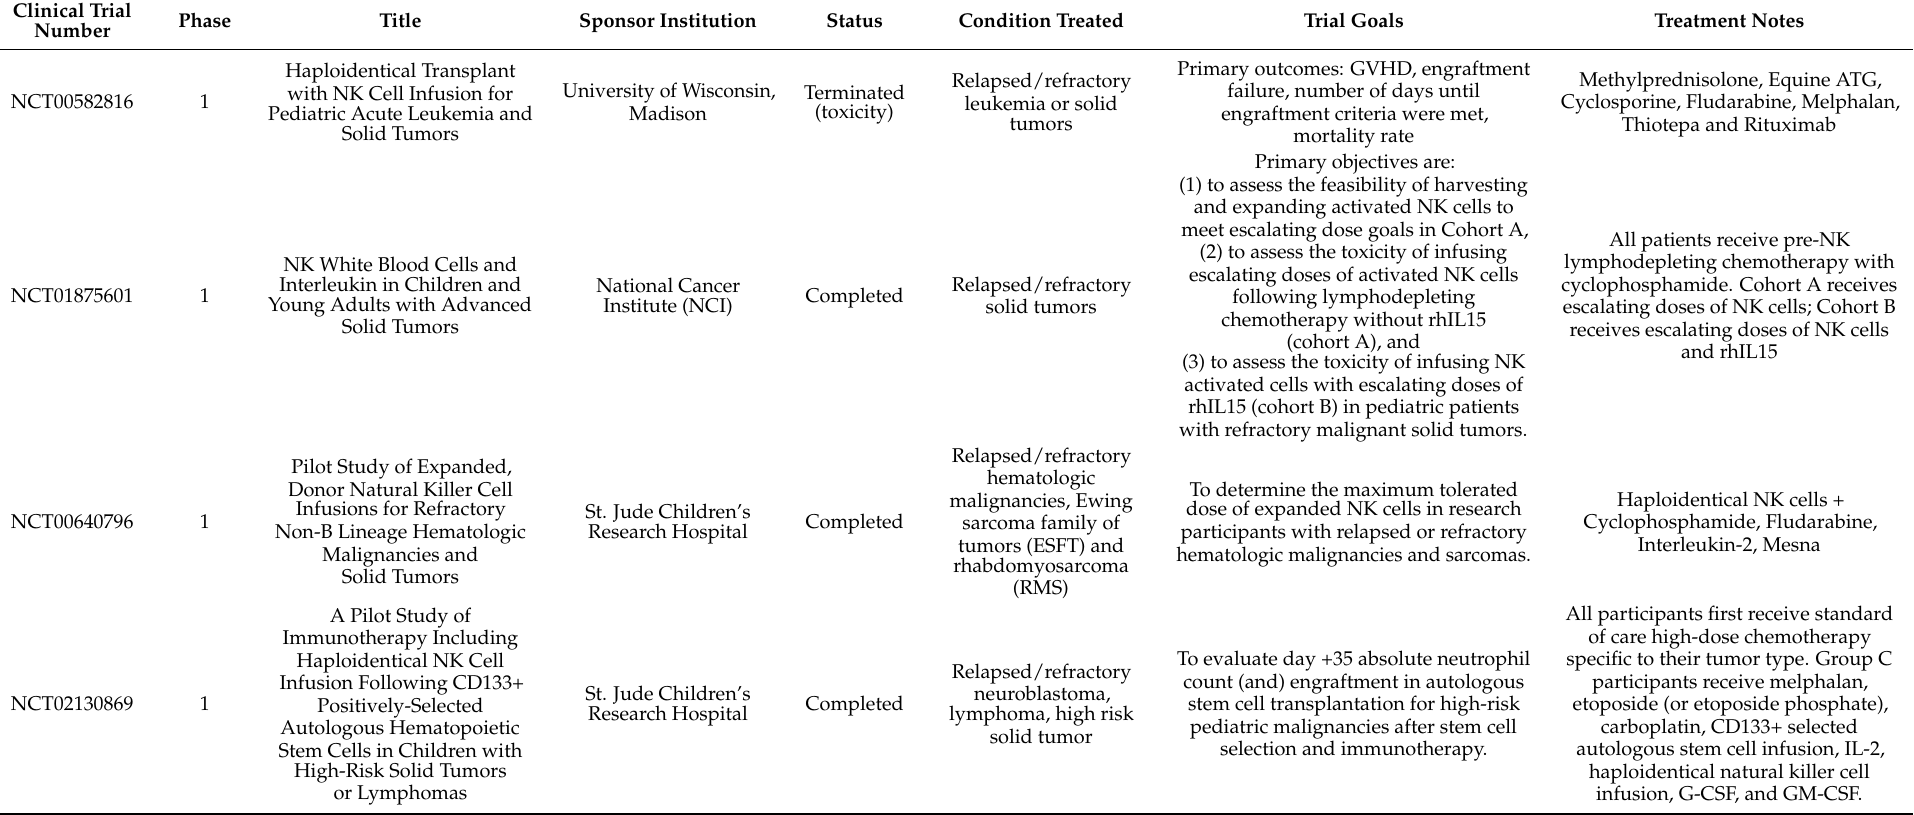
Table 2. Current pediatric clinical trials including adoptive NK cell